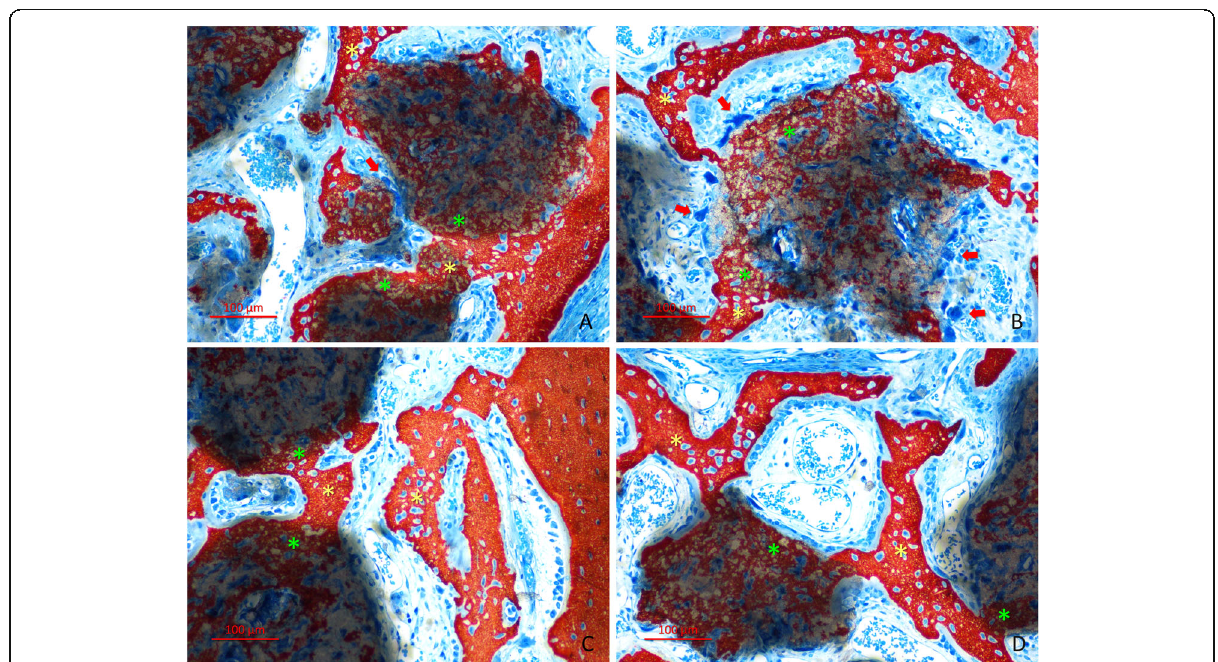
Fig. 2 Graft particles showing various grades of resorption after 2 weeks of healing. New bone was found surrounding the graft particles in the periphery (outer bone; OB) and spreading inward the graft particles in small quantities (interpenetrating bone network; IBN). Soft tissues, cells and vessels are visible within the graft. Osteoclastic zones were found in the periphery of the graft (red arrows in a and b indicate some examples). a , b Plasma group. c , d Control group. a – c Bone wall regions. b – d Sub-mucosa regions. The asterisks indicate examples of OB (yellow) and IBN (green). Stevenel ’ s blue and alizarin red